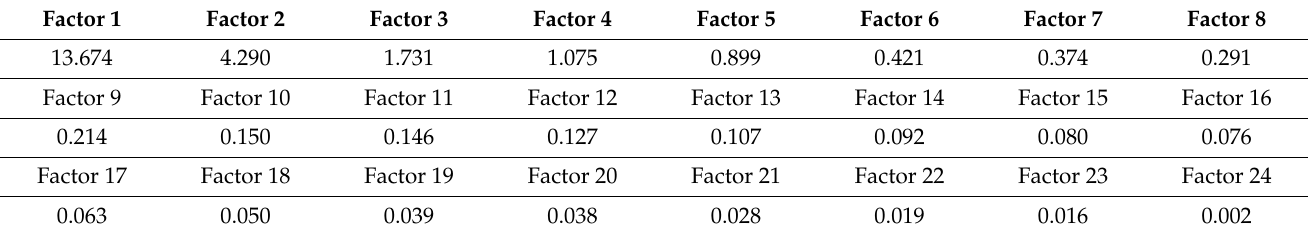
Table 1. Results of the eigenvalue analysis.